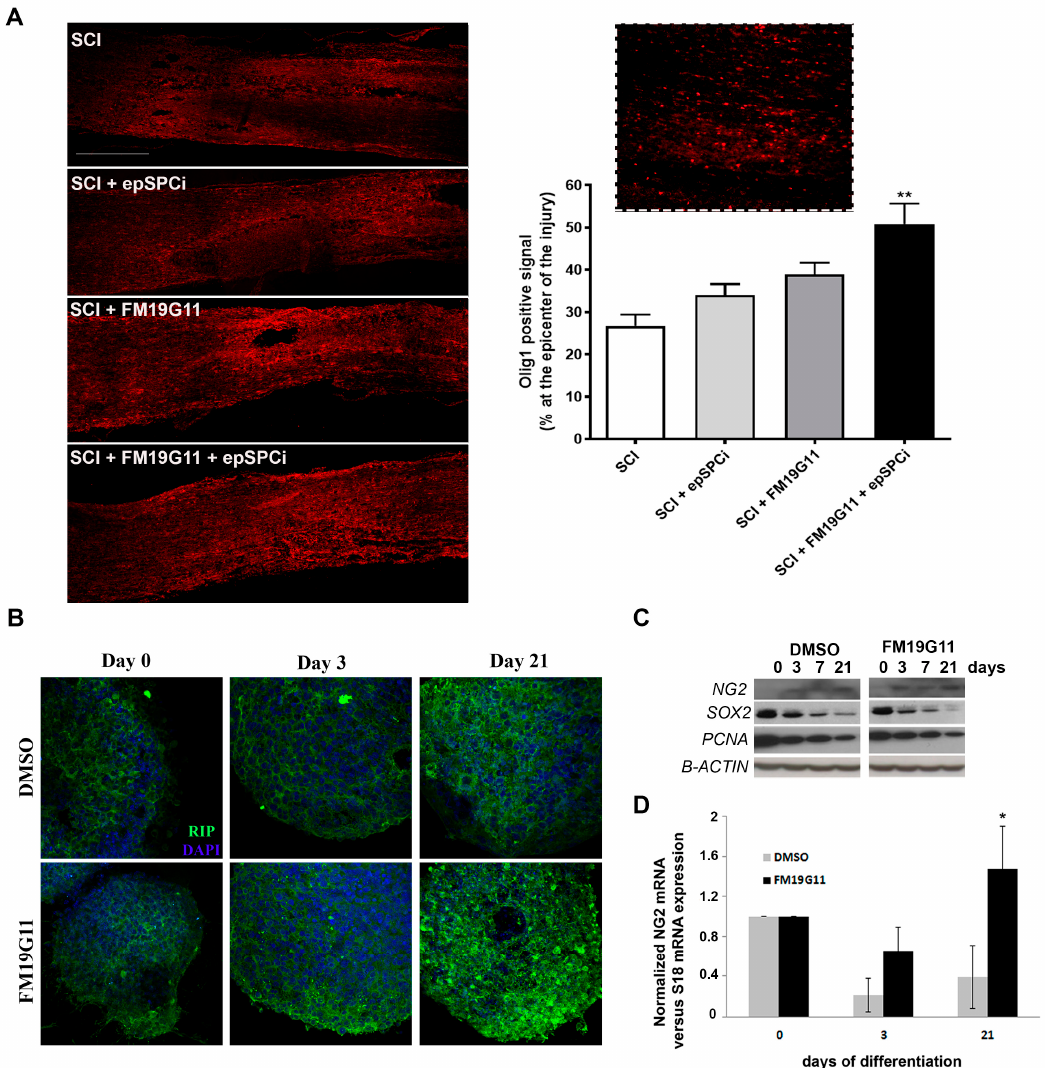
Figure 5. FM19G11 promotes in vivo and in vitro oligodendrocyte turnover. ( A ) ( left panel) Representative immunofluorescent images of the Olig1-positive signal at the epicenter of the injury in every experimental condition (scale bar, 500 µm); ( right panel) quantification of the positive signal for Olig1 expressed as a percentage of the total epicenter area, equivalent in length for all tested groups. Inset: high magnification of Olig1 immunostaining. Quantitative data are expressed as the mean ± S.E.M. ** p < 0.01 in comparison with SCI (control); ( B ) representative immunofluorescent images of RIP (mature oligodendrocyte marker) at different time points through the directed induced oligodendrocyte differentiation process of epSPCi in culture in the presence of FM19G11 or vehicle (DMSO) (scale bar, 500 µm); ( C ) western blotting of NG2, Sox2, PCNA and β -actin semi-quantitative expression and ( D ) quantitative RT-PCR analysis for the expression of NG2 (oligodendrocyte marker) at the different stages of the directed in vitro differentiation process into oligodendrocytes from epSPCi in the presence of FM19G11 or DMSO (vehicle), * p < 0.05 in comparison with DMSO.